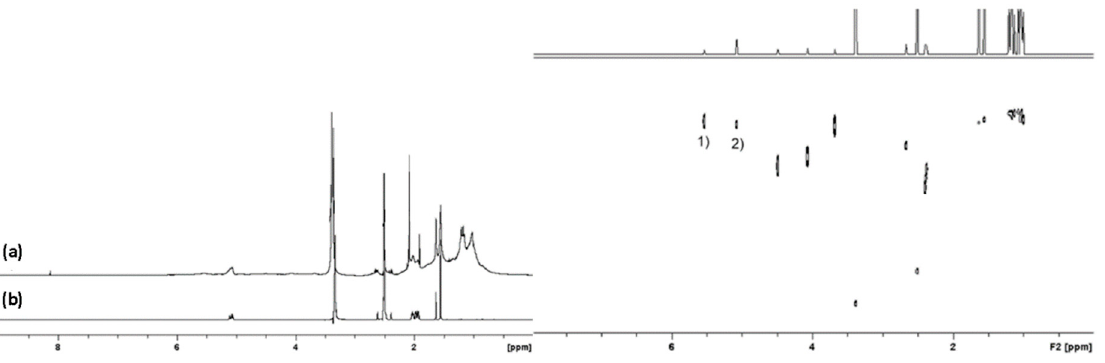
Figure 2. ( Left ) 1 H-NMR comparison of (a) squalene under 285 nm UV light for 10 days and (b) squalene not exposed to UV light. ( Right ) 1 H DOSY NMR spectrum showing the diffusion signals (1) and (2) for the putative oligomeric squalene.